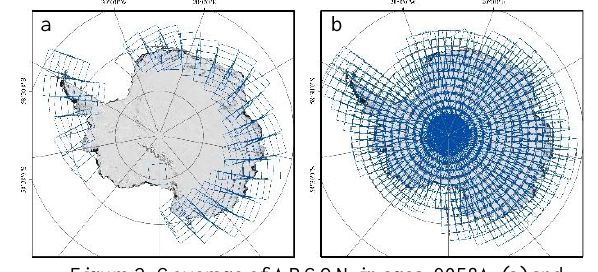
Figure 2. Coverage of ARGON images, 9058A (a) and 9059A (b)